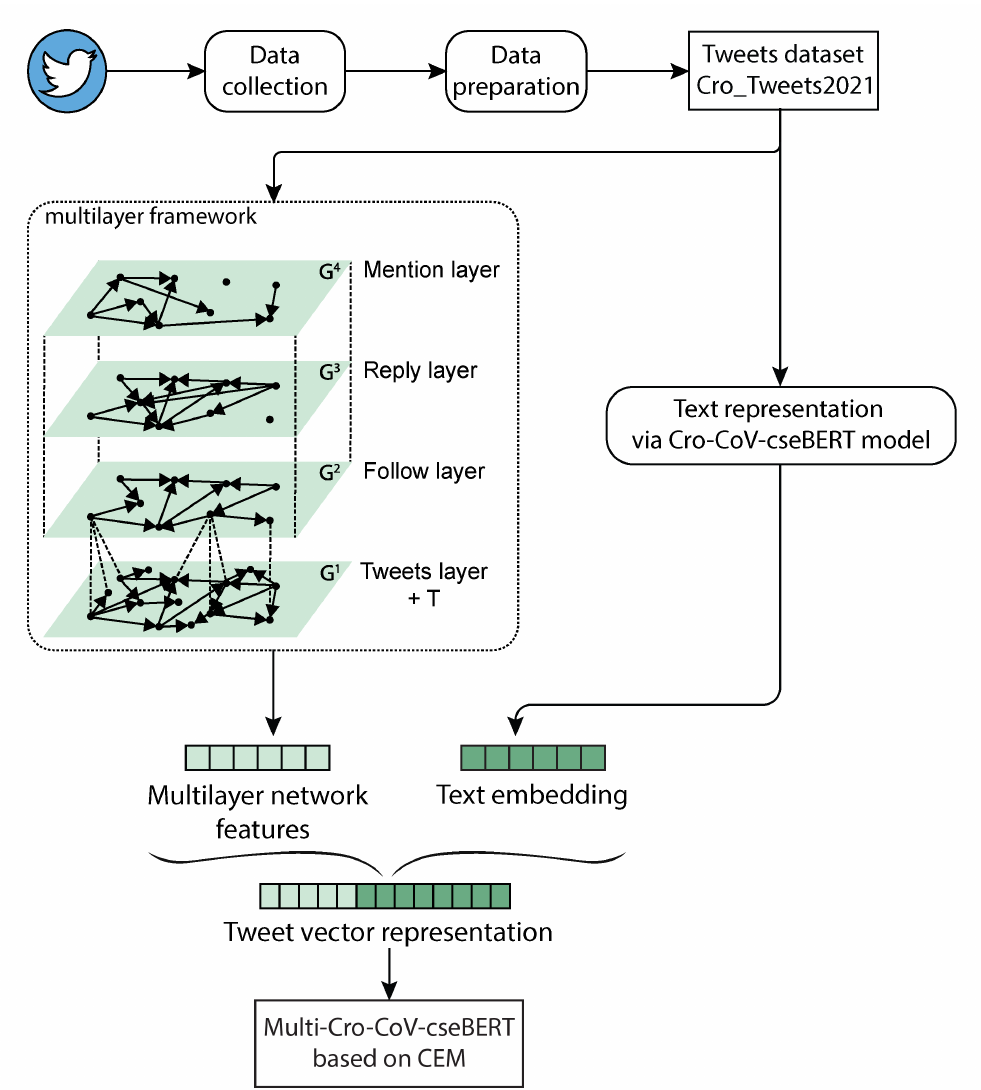
Figure 2. Tweets processing